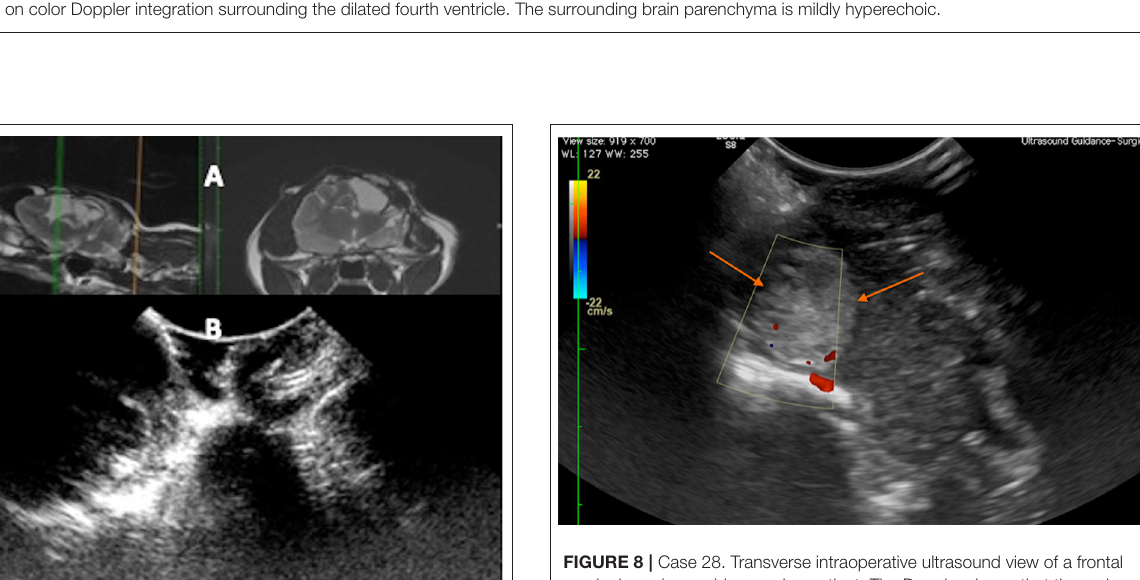
supply to the tumor, bleeding at the operative site, and bleeding as a result of the biopsy are very beneficial at the time of